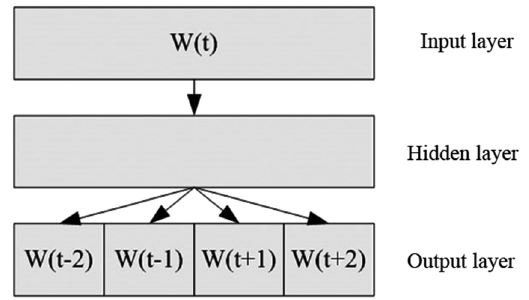
Figure 2: The Skip - gram model in